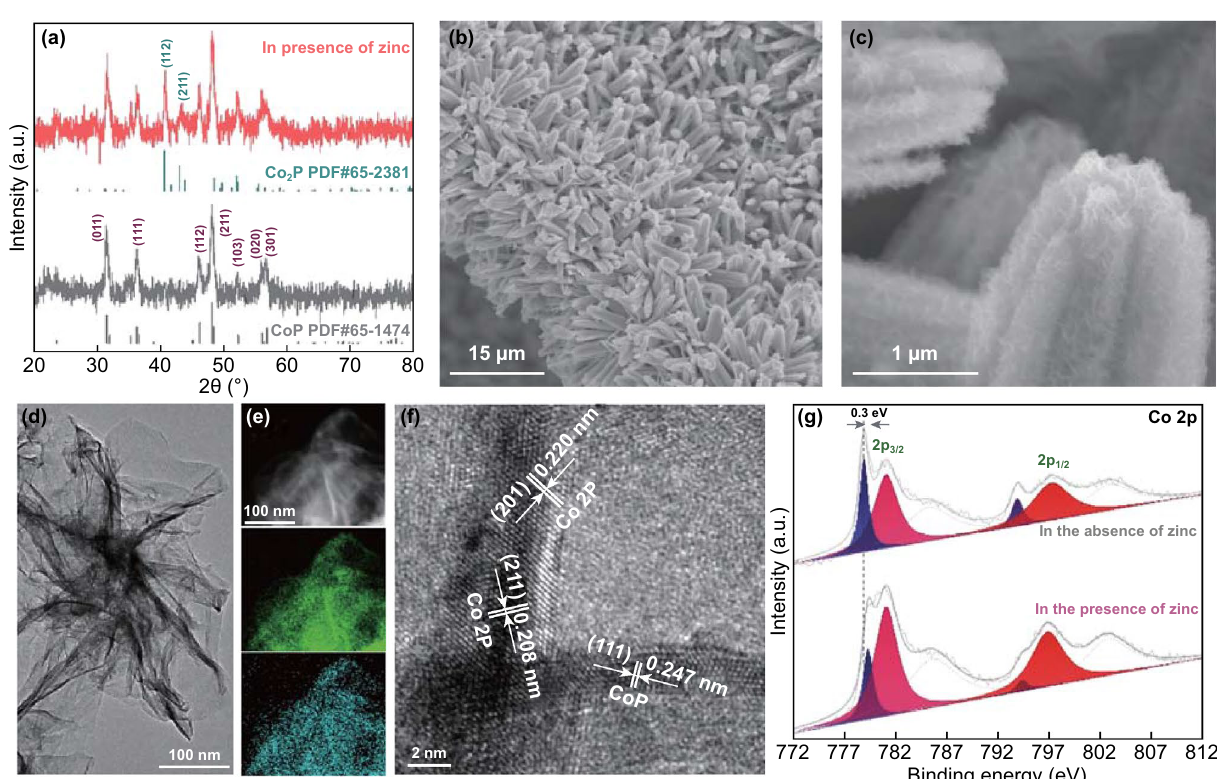
Fig. 2 a X‑ray diffraction patterns of pure CoP and Co 2 P/CoP NAs. b , c SEM images of Co 2 P/CoP NAs‑loaded electrode. d TEM images of